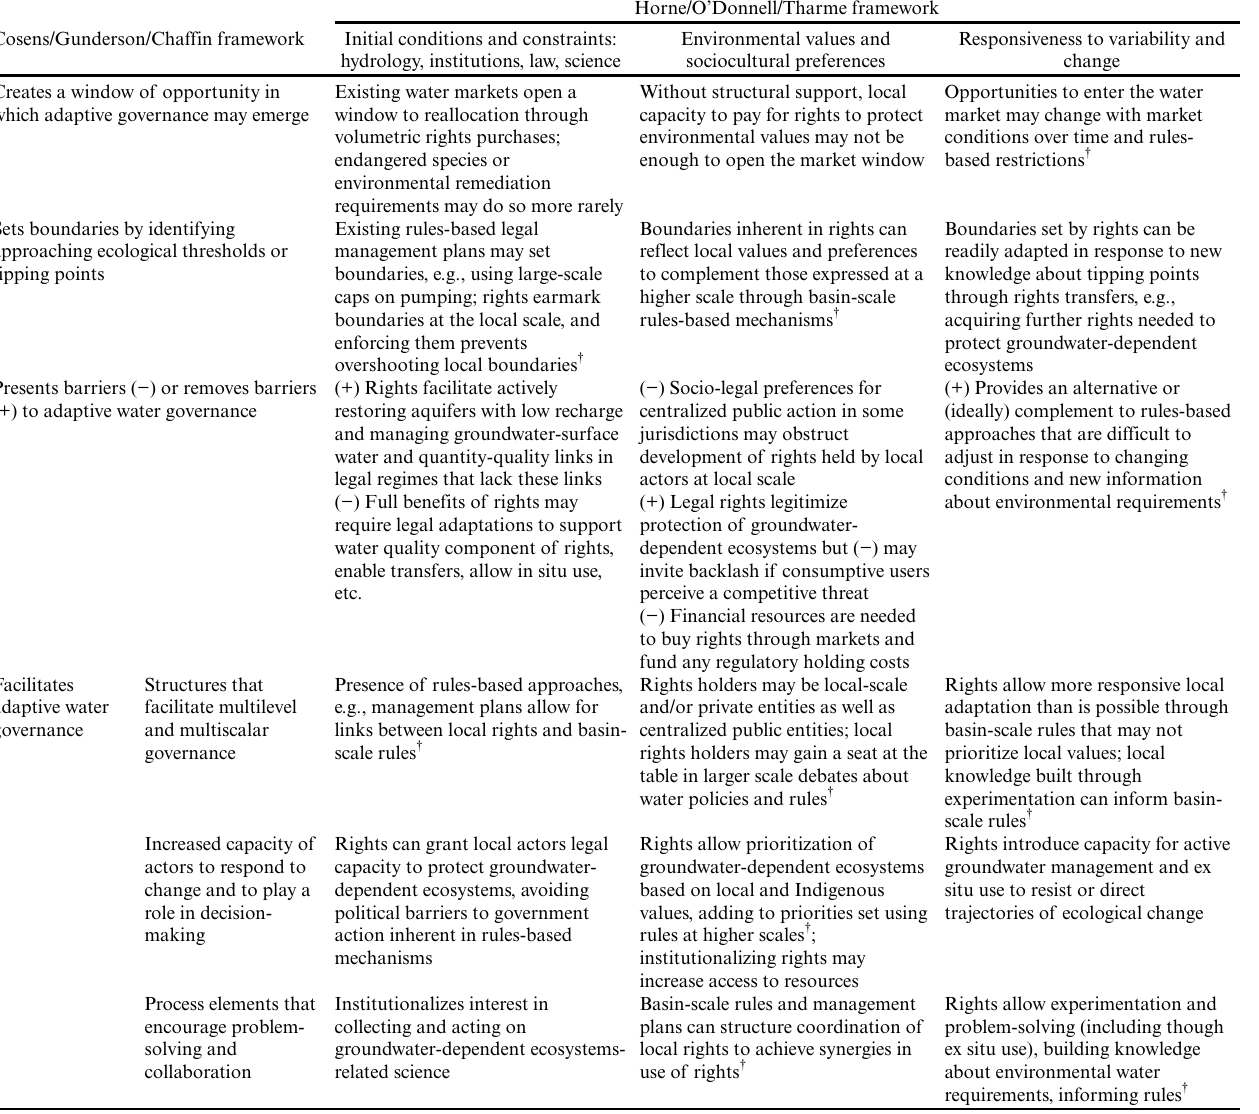
Table 2. Benefits and challenges of environmental groundwater rights (“rights”). Insights from applying the Horne/O’Donnell/Tharme framework (Horne et al. 2017 a ; columns) and implications for adaptive water governance as per the Cosens/Gunderson/Chaffin framework (Cosens et al. 2014; rows). See Appendix 1 for an example of a case scenario that investigates how some of these factors might arise in